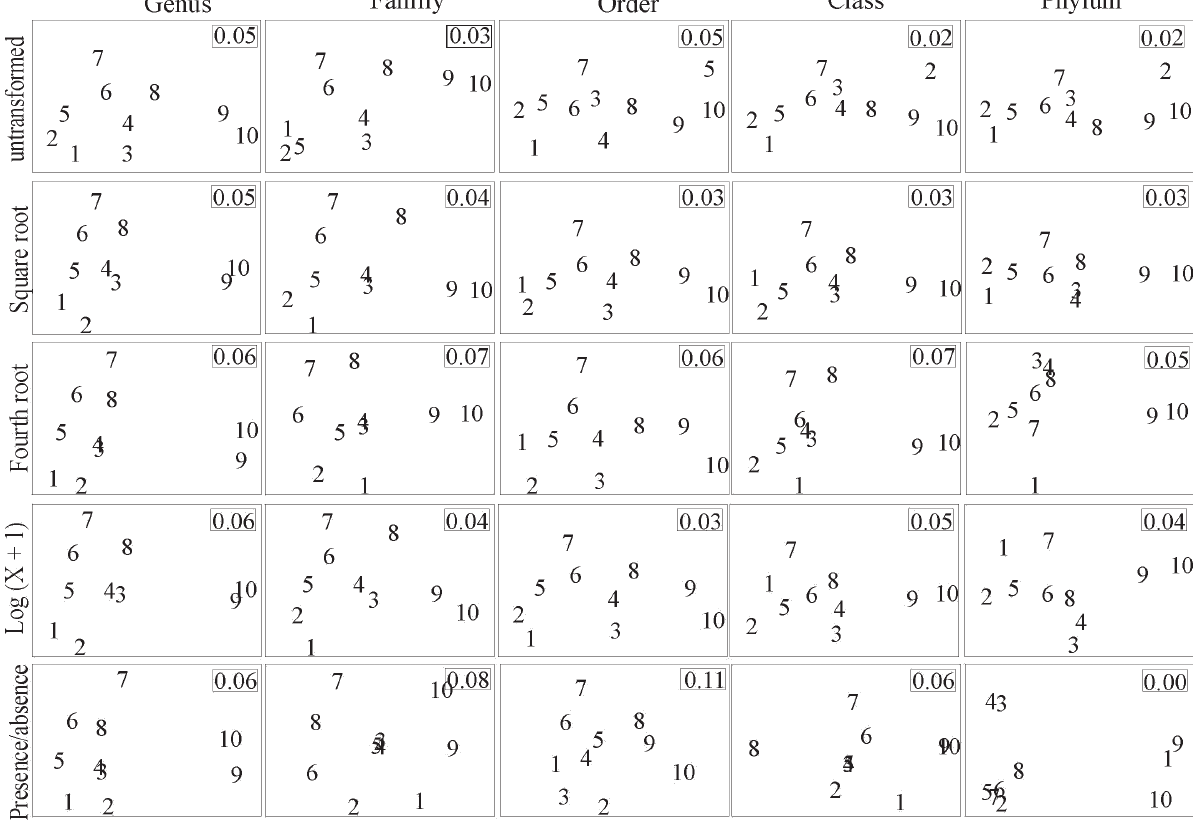
TAXONOMIC AGGREGATION, REDUNDANCY AND TEMPORAL PATTERNS 139